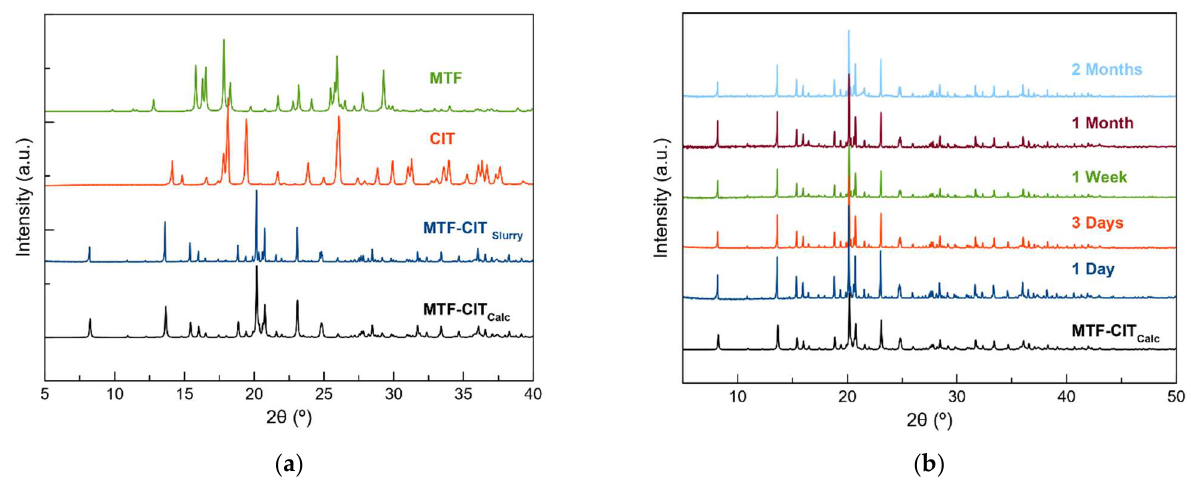
Figure 7. Stability experiments. Comparison between the calculated pattern of MTF–CIT with those of the slurry in water 24 h ( a ). Stability of MTF–CIT in accelerated aging conditions ( b ).